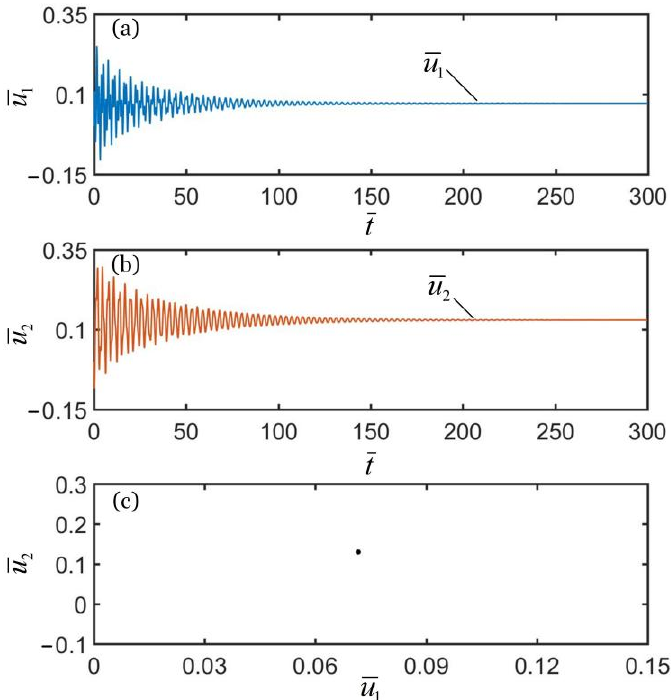
Figure 3. Time histories and domain of attraction of anti-phase synchronous regime of light-powered LCE self-excited coupled oscillators for k 2 = 4.5. ( a ) u 1 vs. t ; ( b ) u 2 vs. t ; ( c ) domain of attraction. The two couple oscillators are in anti-phase regime.